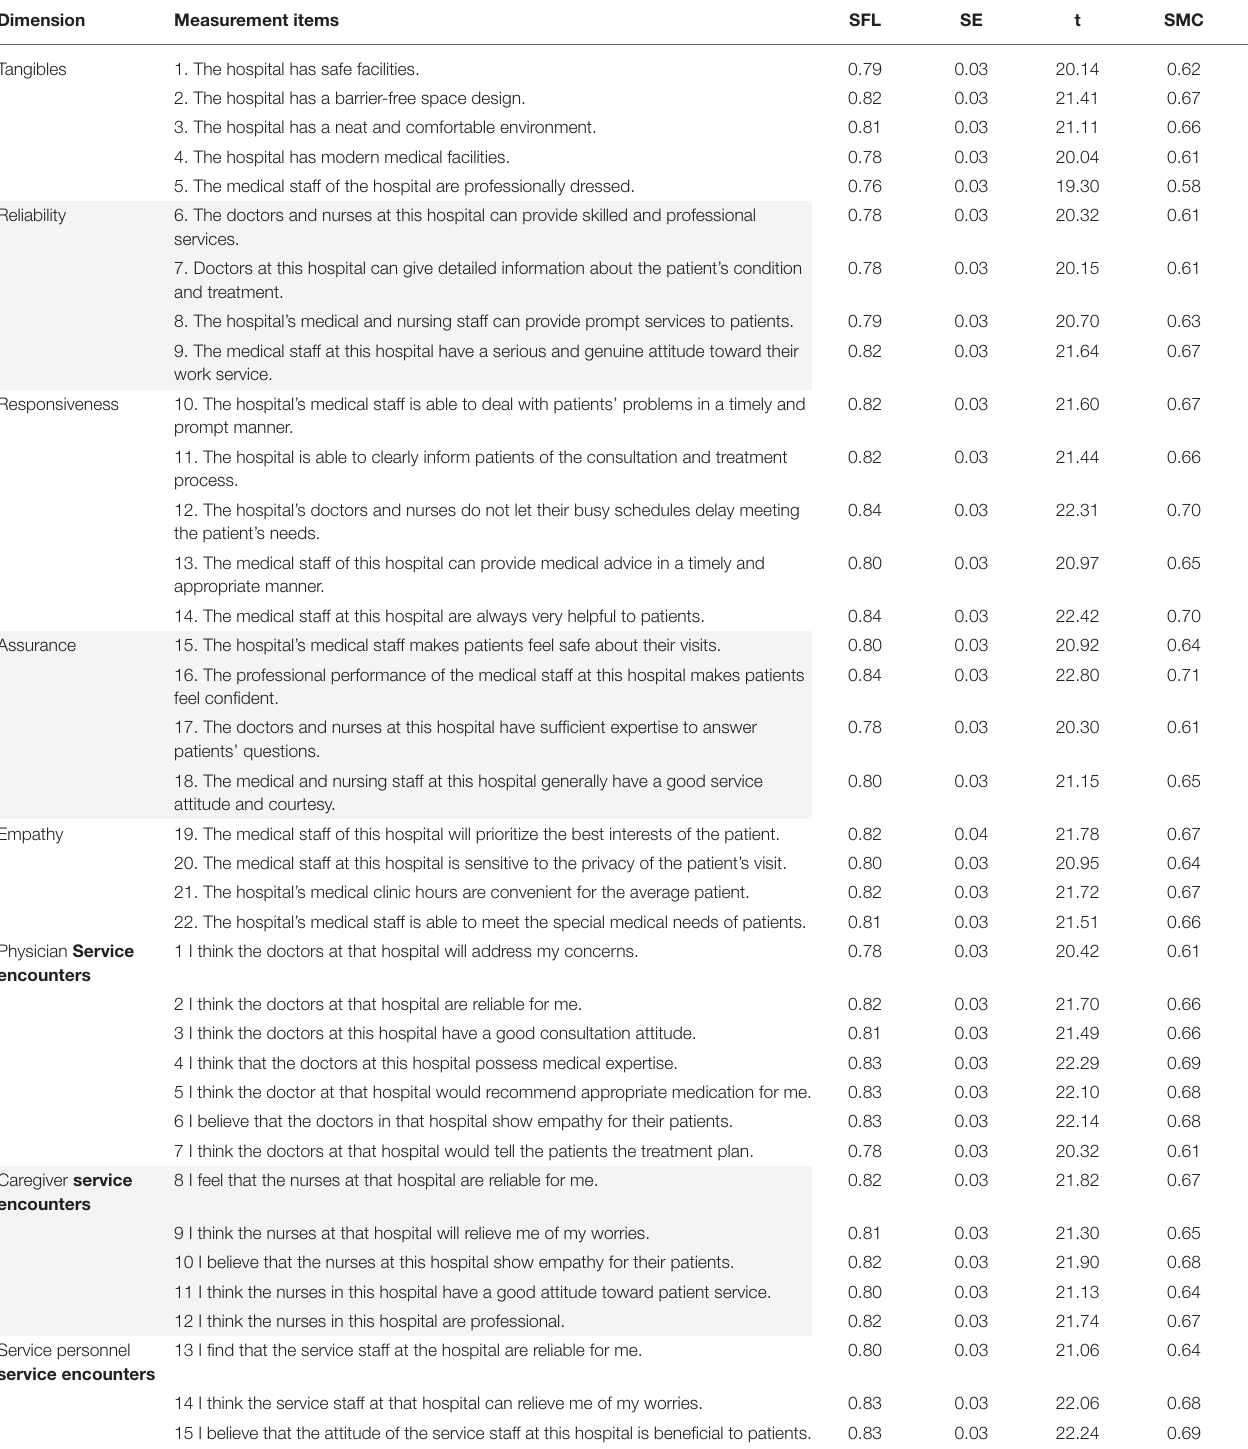
TABLE 4 | Confirmatory factor analysis of the research model ( n = 483). Measurement